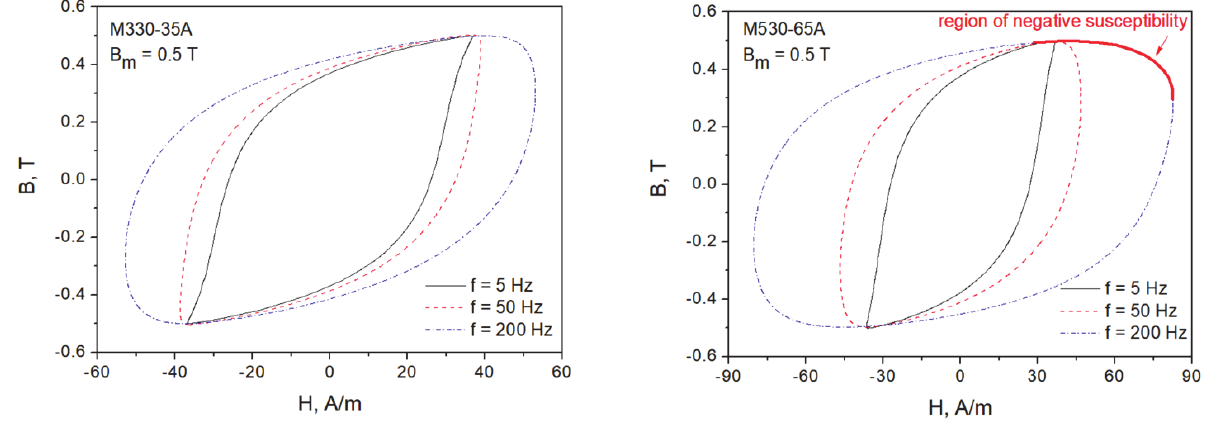
Figure 2. Measured hysteresis loops for two NO steel grades at B m = 0.5 T. At the increased excitation frequency, the regions with negative dynamic susceptibility are clearly visible.